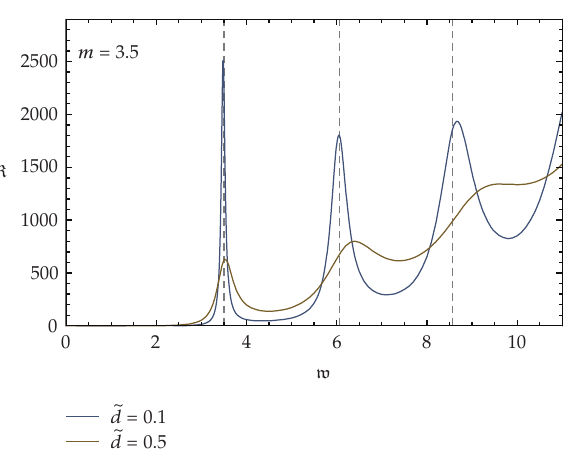
Figure 11: The dependence of the spectra on baryon density. The dashed lines again mark the supersymmetric spectrum.